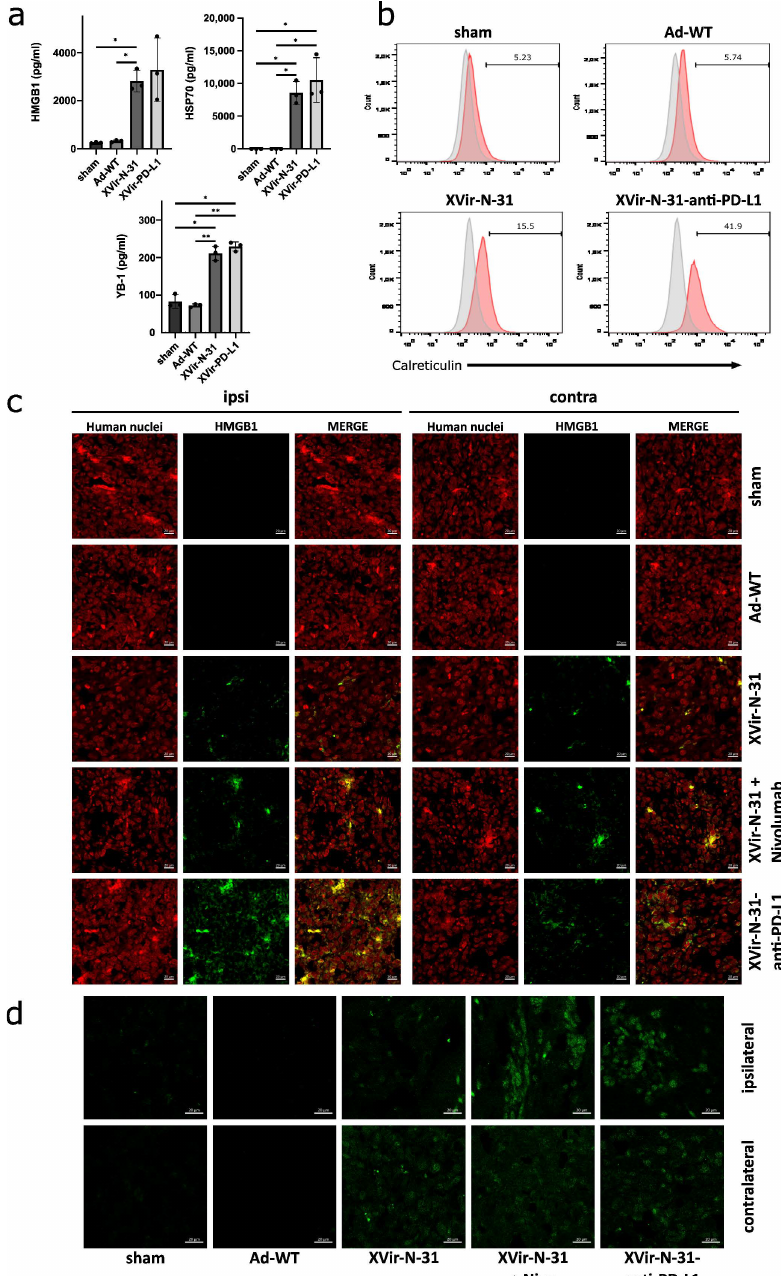
Figure 3. Induction of immunogenic cell death by XVir-N-31 and XVir-N-31-anti-PD-L1. ( a ) U87MG cells were infected with 50 MOI XVir-N-31 or XVir-N-31-anti-PD-L1, or with 20 MOI Ad-WT, or were left untreated. Supernatants were taken at the timepoint the cultures showed 50% oncolysis, and were analyzed for HMGB1, HSP70, or YB-1 release by ELISA (XVir-PD-L1: XVir-N-31-anti-PD-L1). ( b ) CRT surface expression was analyzed in the U87MG cells at the same conditions as indicated in A (n = 3; SEM; * p < 0.05; ** p < 0.01). ( c ) The detection of HMGB1 in U87MG ipsilateral virus-injected and contralateral tumors 35 days after intratumoral injection of either PBS (sham), 3 × 10 8 IFU of either Ad-WT, of XVir-N-31 alone or in combination with multiple systemic applications of nivolumab, or of XVir-N-31-anti-PD-L1 (n = 7–8 mice per group; representative pictures are shown). ( d ) Enlightenment of the HMGB1 staining as indicated in ( c